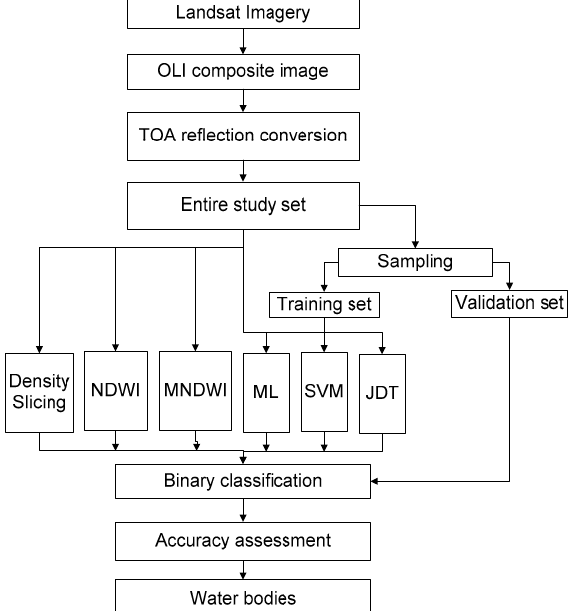
Figure 1. Overall flowchart adopted in this study.